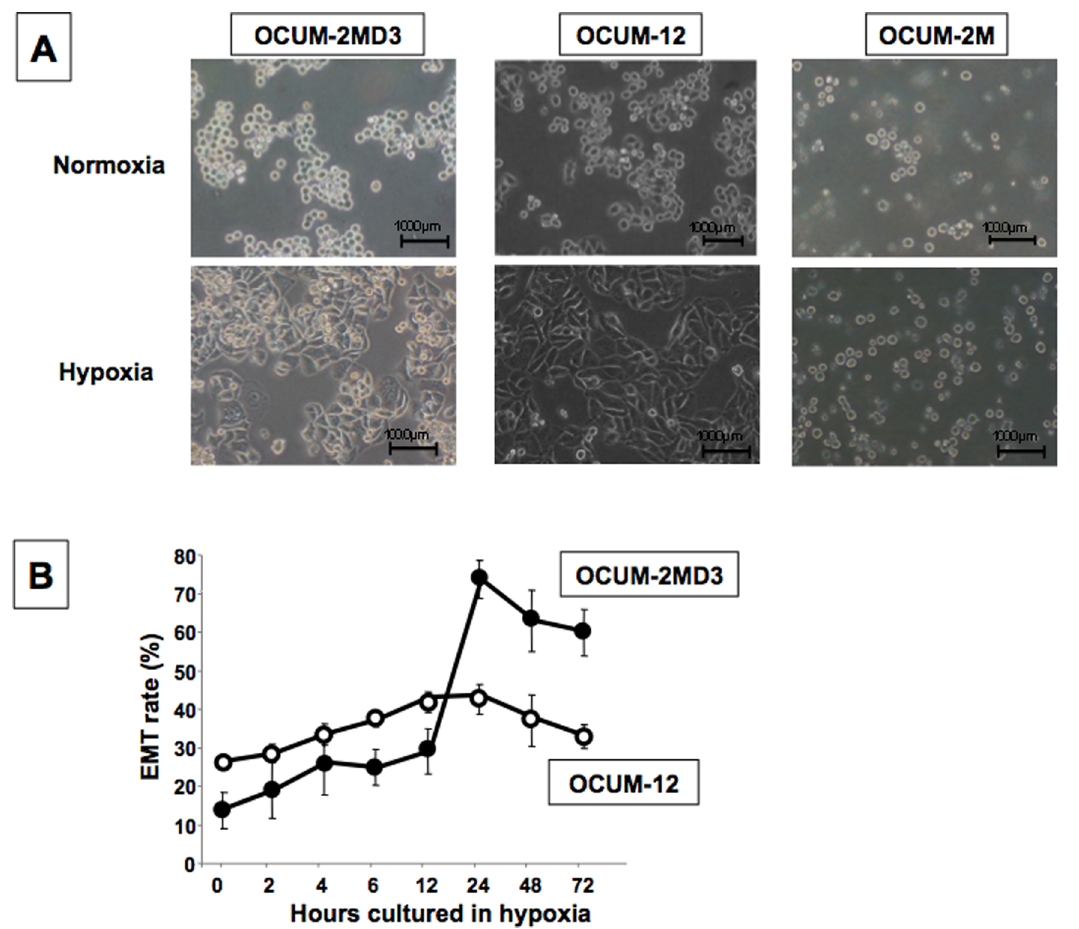
Figure 1. Morphologic changes of gastric cells under a hypoxic condition. (A) An increase of polygonal or spindle-shape cells was recognized in OCUM-2MD3 and OCUM-12 cells under hypoxia, but not in OCUM-2M cells. (B) The morphology of OCUM-2MD3 and OCUM-12 cells began to change after 4 h in hypoxic culture. EMT of OCUM-2MD3 and OCUM-12 cells was most evident at 24 h of culture under hypoxia. EMT was determined when the polygonal or spindle shape was found in cancer cells by phase-contrast microscope.